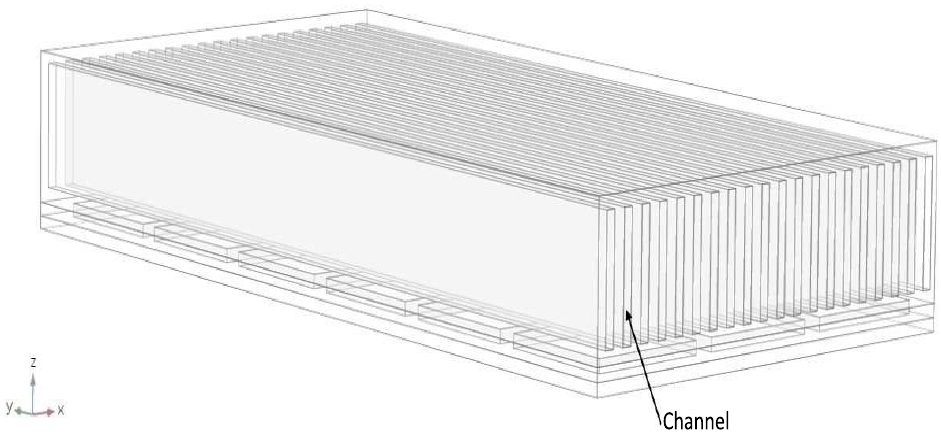
Figure 10. The 1D thermal resistance model vs. COMSOL model.